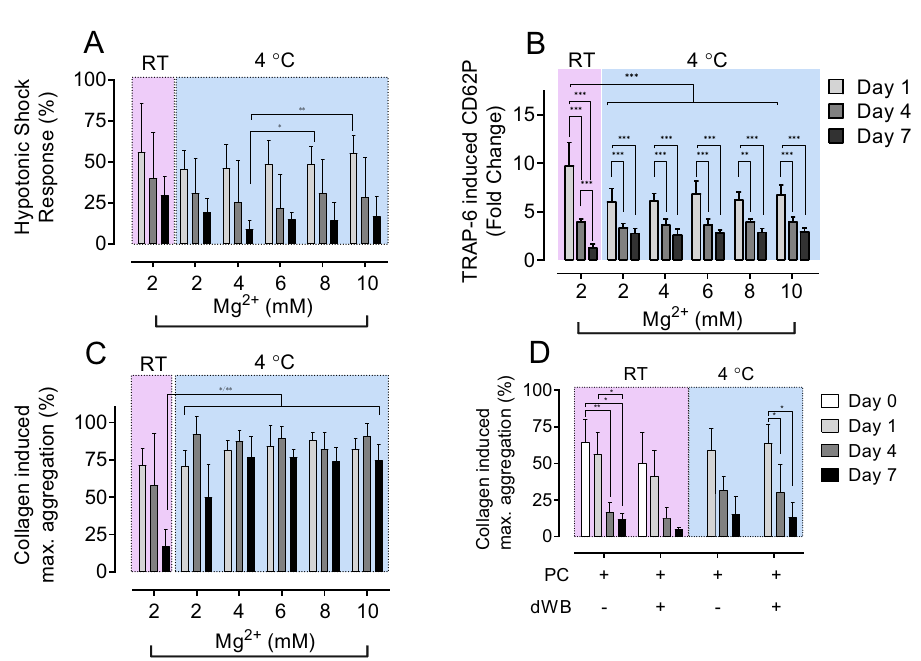
Figure 1. ( A ) Hypotonic shock response, ( B ) fold increase of CD62P mean fluorescence intensity after 20 µM TRAP-6 addition in comparison to buffer-control, and ( C ) maximum aggregation after 8 µg/mL collagen I addition to platelets from PC stored at RT + 2 mM Mg 2+ , 4 °C + 2, 4, 6, 8 or 10 mM Mg 2+ (n = 6, mean ± SD). ( D ) Maximum aggregation after 8 µg/mL collagen I addition to platelets from PC stored at RT or 4 °C either subsequently added to platelet depleted, tempered whole blood (dWB) or not (n = 6, mean ± SD). PC platelet concentrate, RT room temperature, Mg 2 + magnesium, SD standard deviation, *p < 0.05, **p < 0.01, ***p < 0.001, Statistical analysis is performed using one way ANOVA with multiple